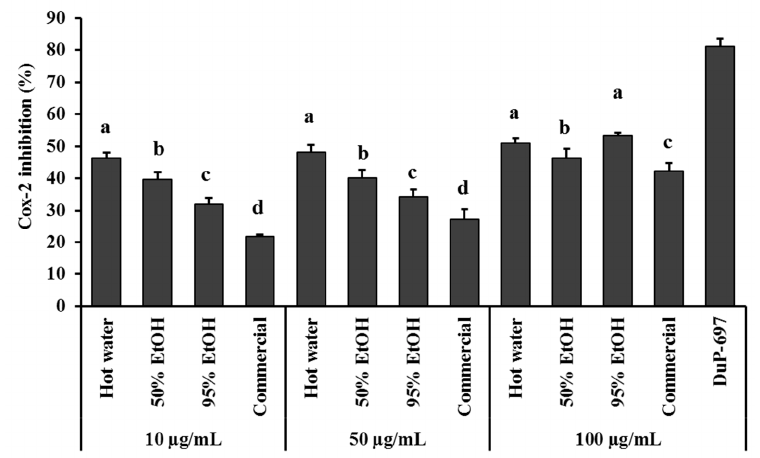
Figure 4. Effect of P. emblica L. fruit extracts on cyclooxygenase -2 (COX-2) inhibition. DuP-697 is a COX-2 enzyme inhibitor used as a positive control. Data are means ± SD ( n = 3). Values for different sample concentrations (10, 50 and 100 µg/mL) with different superscript letters (a, b, c and d) indicate a significant difference ( p < 0.05) by Duncan’s multiple range test.